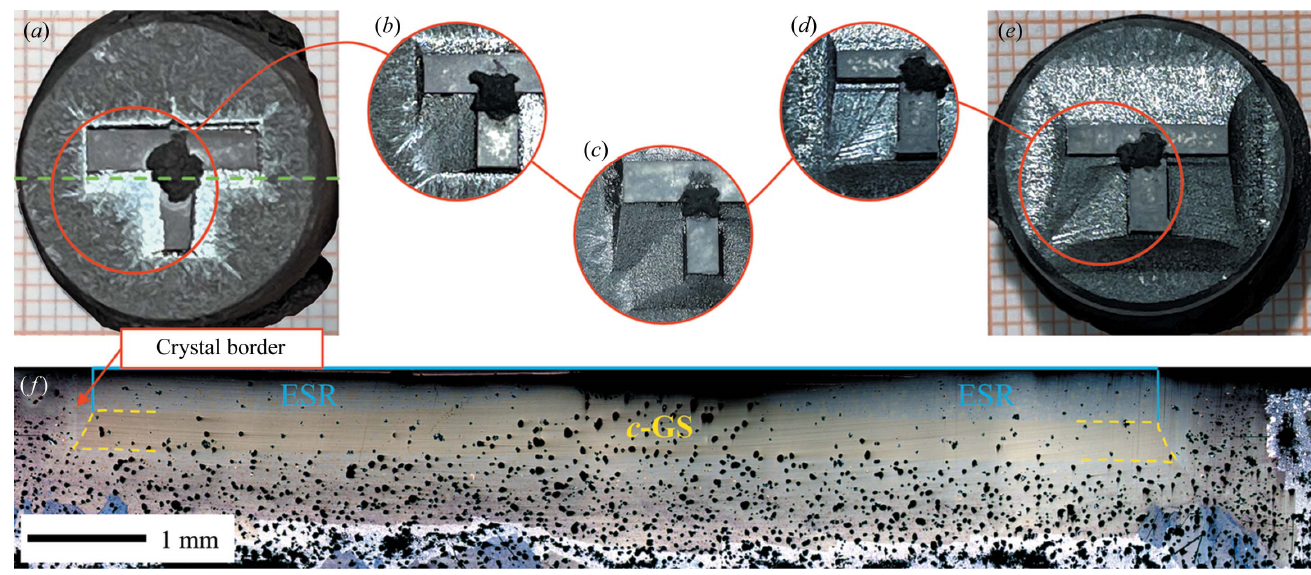
Figure 10 ( a )–( e ) Photographs showing the intermediate states of TSLG from a series of T-seeded samples. Each photograph in ( b )–( d ) shows one concave. ( f ) Cross-sectional image obtained by cutting the sample along the green dashed line in ( a